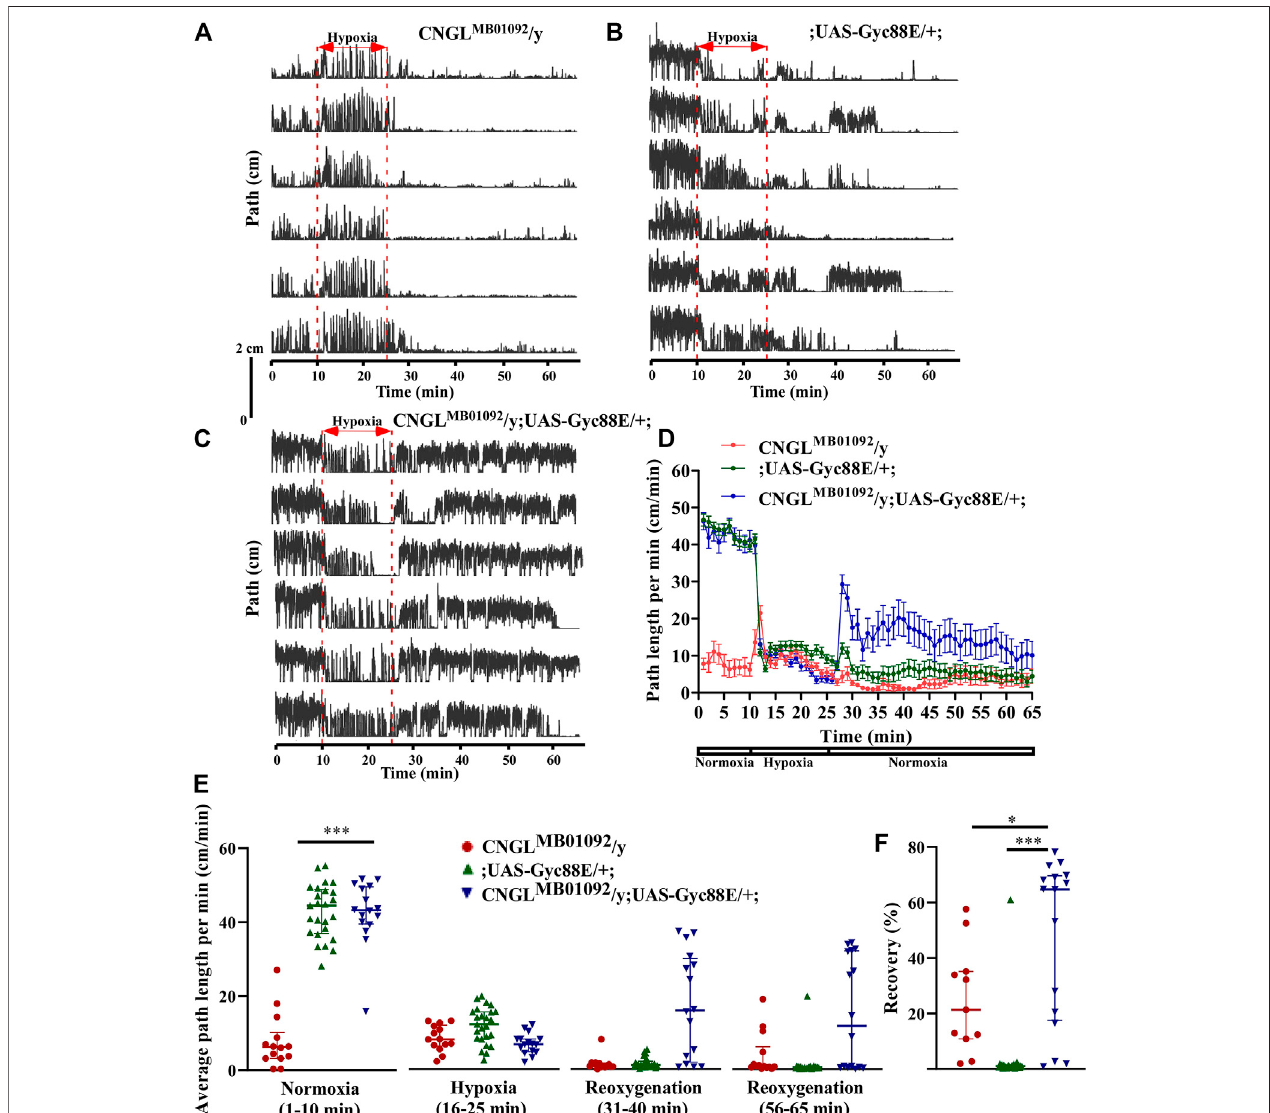
FIGURE 5 | Overexpression of Gyc88E eliminated both the reduced locomotor activity under normoxia and the reduced recovery in response to hypoxia in CNGL mutant. (A – C) Locomotor analysis for fl ies with Gyc88E overexpression and control fl ies with hypoxia. (D) Path length per minute of control fl ies (CNGL MB01092 /y, red circles and red line, n = 12, and ;UAS-Gyc88E/+; , green circles and green line, n = 29) and CNGL mutant fl ies with Gyc88E overexpression (CNGL MB01092 /y; UAS- Gyc88E/+; , blue circles and blue line, n = 16) during normoxia, hypoxia and recovery. (B) The average path length per minute under normoxia (1 – 10 min), during hypoxia(16 – 25 min),andduringreoxygenation(31 – 40minand56 – 65 min)ofcontrol fl iesand CNGL mutant fl ieswithGyc88Eoverexpression. (C) Thepercentrecovery ofcontrol fl iesand CNGL mutant fl ieswithGyc88Eoverexpression. (E) Theaveragepathlengthperminuteundernormoxia(1 – 10 min),duringhypoxia(16 – 25